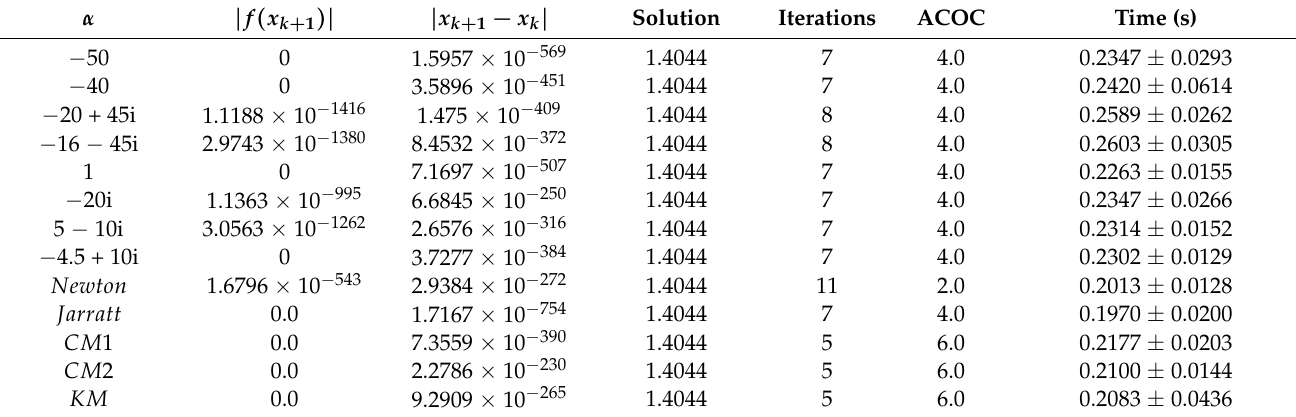
Table 2. f 1 ( x ) = sin 2 x − x 2 + 1, x 0 = 4.